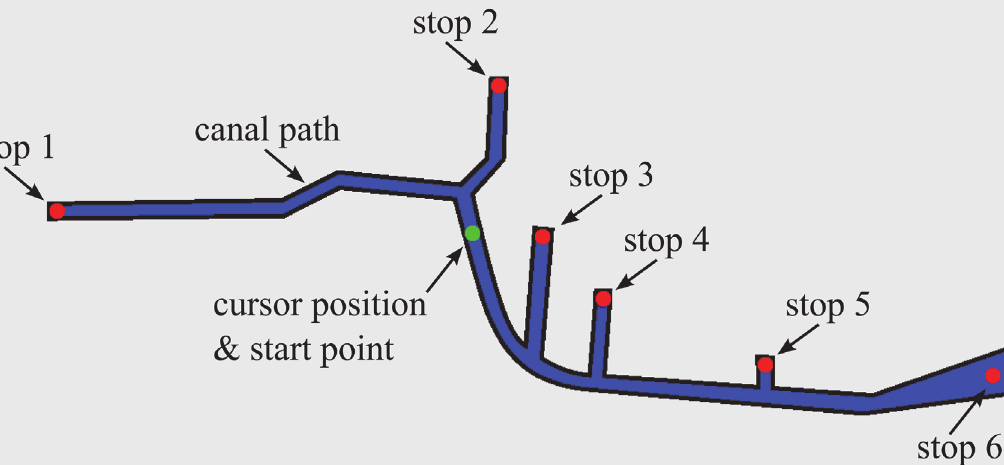
Fig 2. Path displayed to users in map mode, with overlaid dots displaying waypoints (red) and cursor start position (green). The image presented to the participants was superimposed on an aerial photo of the Gowanus